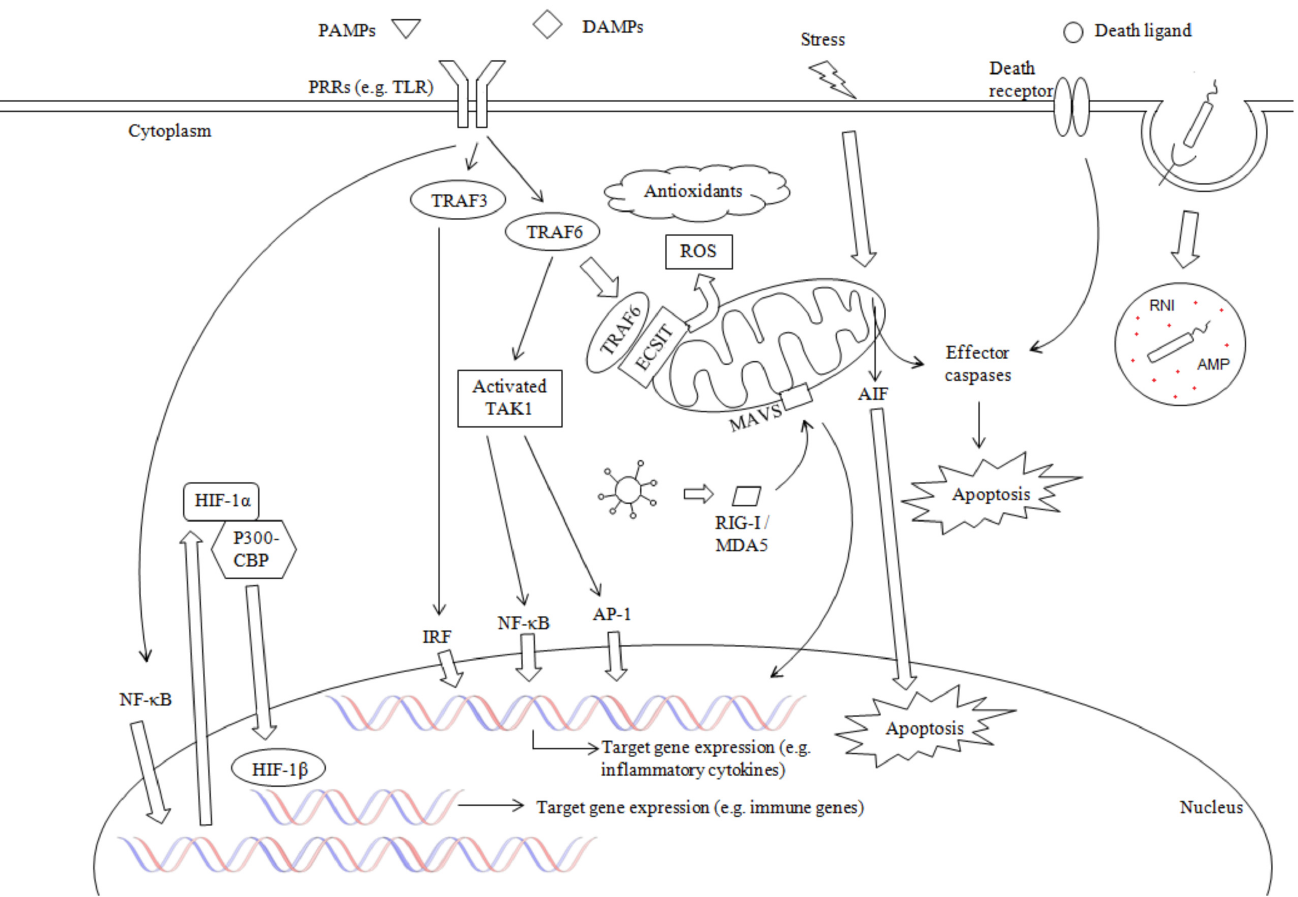
Fig 2. Schematic of the predicted innate immune processes of S . glomerata . S . glomerata innate immune transcripts observed in this study are predicted to be involved in a range of different innate immune processes, (components regulating the different pathways are not visualised in this figure). Abbreviations are as follows: PPRs (pattern recognition receptors), TLR (Toll-like receptor), PAMPs (pathogen-associated molecular patterns), DAMPs (damage-associated molecular patterns), TRAF (tumor necrosis factor receptor-associated factor), TAK1 (transforming-growth-factor- β -activated kinase 1), ROS (reactive oxygen species), ECSIT (evolutionary conserved signalling intermediate in toll pathways), RIG-1/MDA5 (interferon-induced helicase c domain-containing protein 1), MAVS (mitochondrial antiviral-signalling protein), AIF (apoptosis-inducing factor 1), AP-1 (activator protein 1), NF- κ B (nuclear factor kappa B), IRF (interferon regulatory factor), HIF (hypoxia-inducible factor), CBP (CREB-binding protein), RNI (reactive nitrogen intermediates), AMP (antimicrobial peptide). " arrows used in the figure (excluding the ones used in the nucleus) depict signalling pathways.